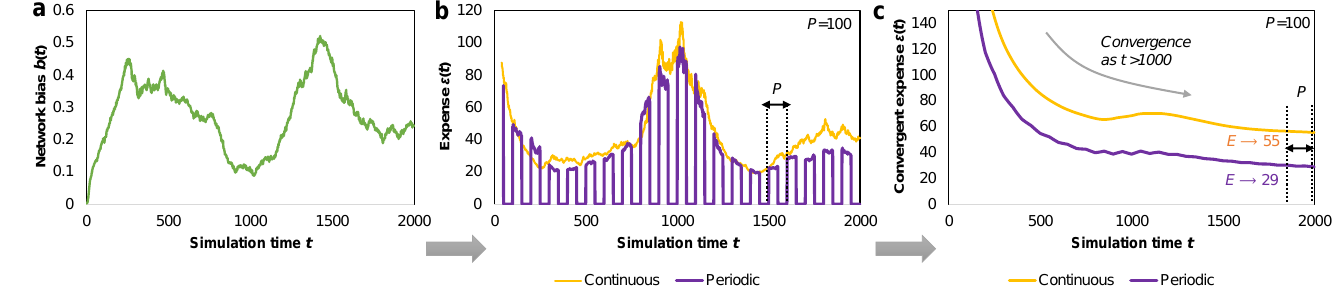
Figure 1. Conceptual representation of the methodology applied to calculate the indoctrination expense: ( a ) experimental measurement of the network bias b ( t ) toward one opinion (green); oscilla- tions emerge due to the existence of multiple competing opinions (not shown here); ( b ) measured indoctrination expense ε ( t ) for the continuous and periodic injection strategies; ( c ) from ε ( t ) , we compute the convergent expense ˜ ε ( t ) which begins to stabilize after approximately t > 1000 iterations; the final indoctrination expense E is calculated as an average of ˜ ε ( t ) over the last P